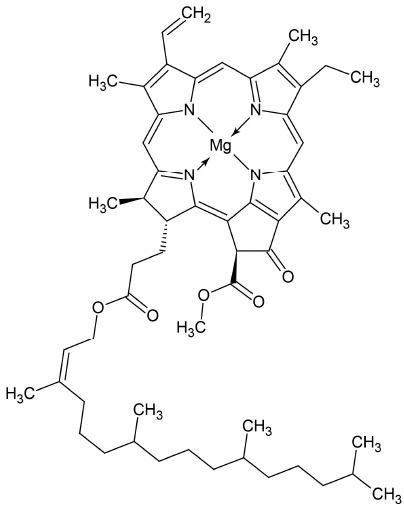
Figure 2. Structure of chlorophyll a 1 .